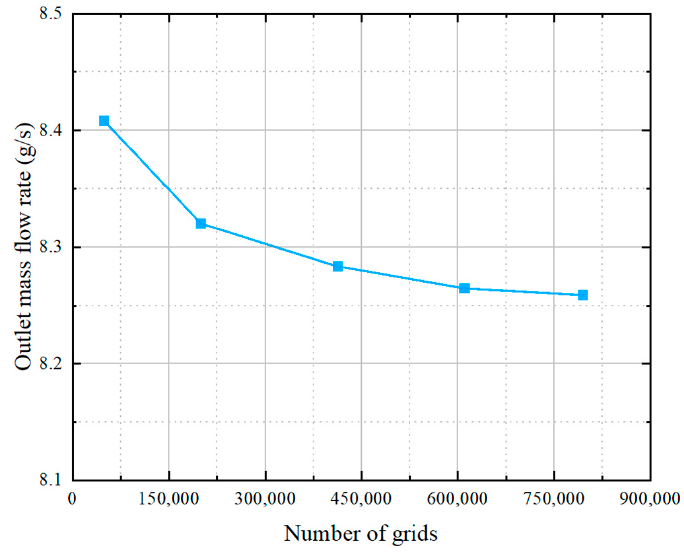
Figure 4. Verification of grid independence based on 80 bar Δ P conditions.